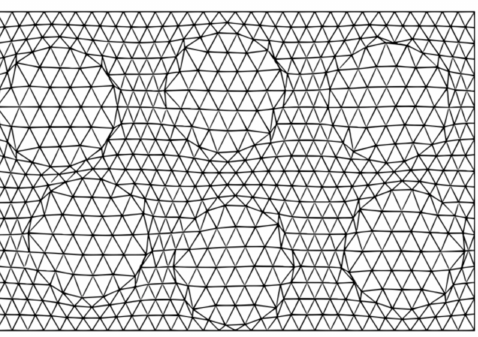
Figure 5. Mesh of the specimen built with 2 layers and 3 RVEs in each